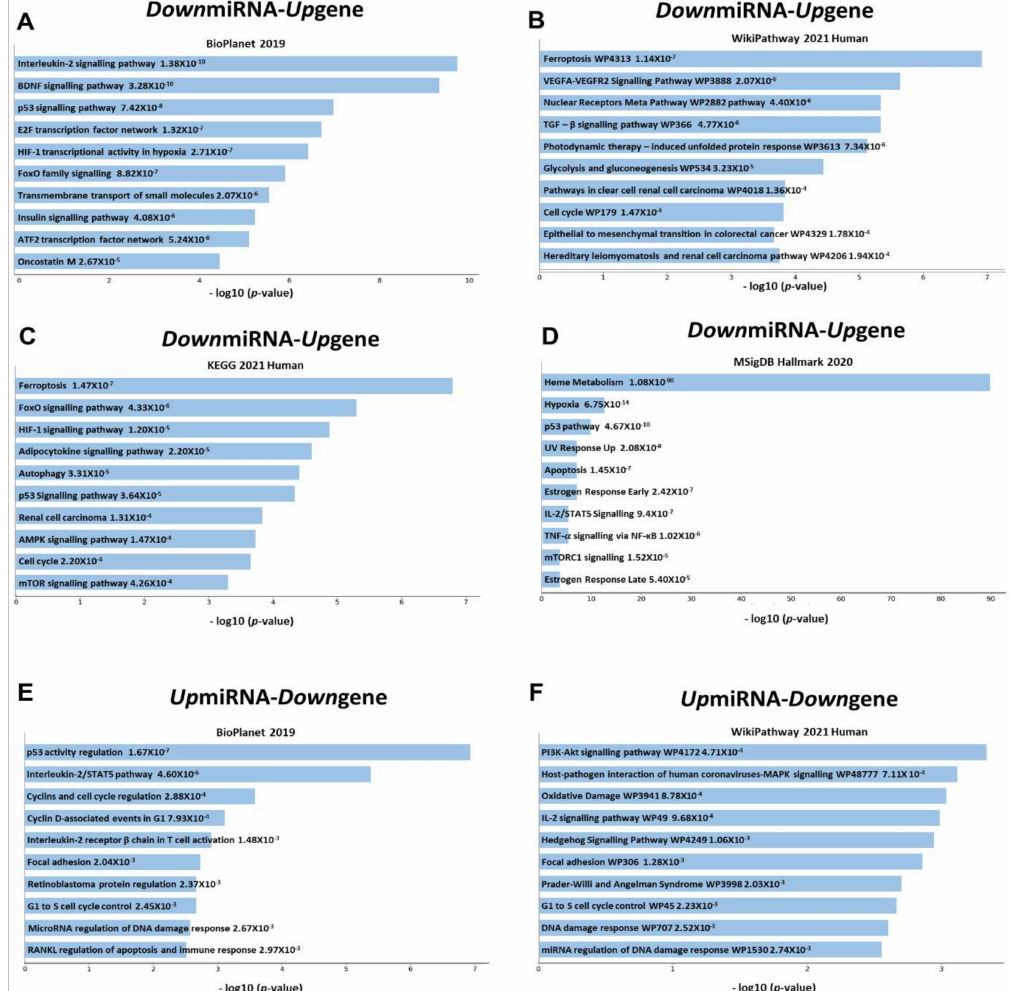
Figure 4. Pathway analysis of the target genes of the differentially expressed miRNAs in erythropoiesis. ( A – D ) Significant pathways identified for the genes in the Down miRNA- Up gene group by ( A ) BioPlanet, ( B ) WikiPathway, ( C ) KEGG, and ( D ) MSigDB Hallmark. ( E , F ). Significant pathways associated with the genes in the Up miRNA- Down gene group by ( E ) BioPlanet and ( F )